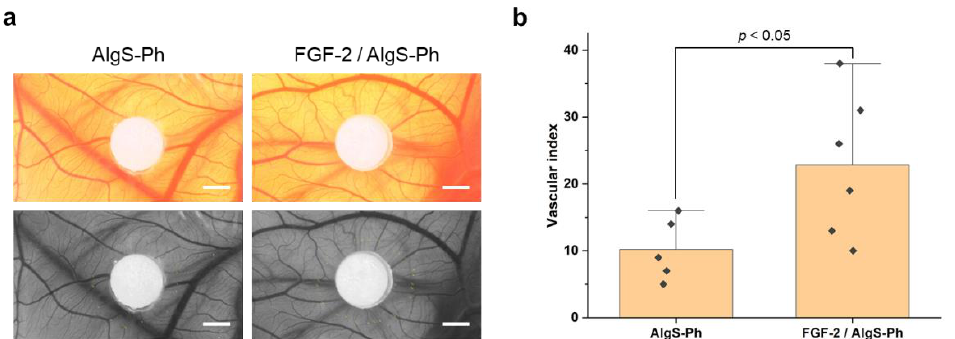
Figure 5. Evaluation of angiogenesis using a chick embryo model. ( a ) Original and 16-bit micrographs